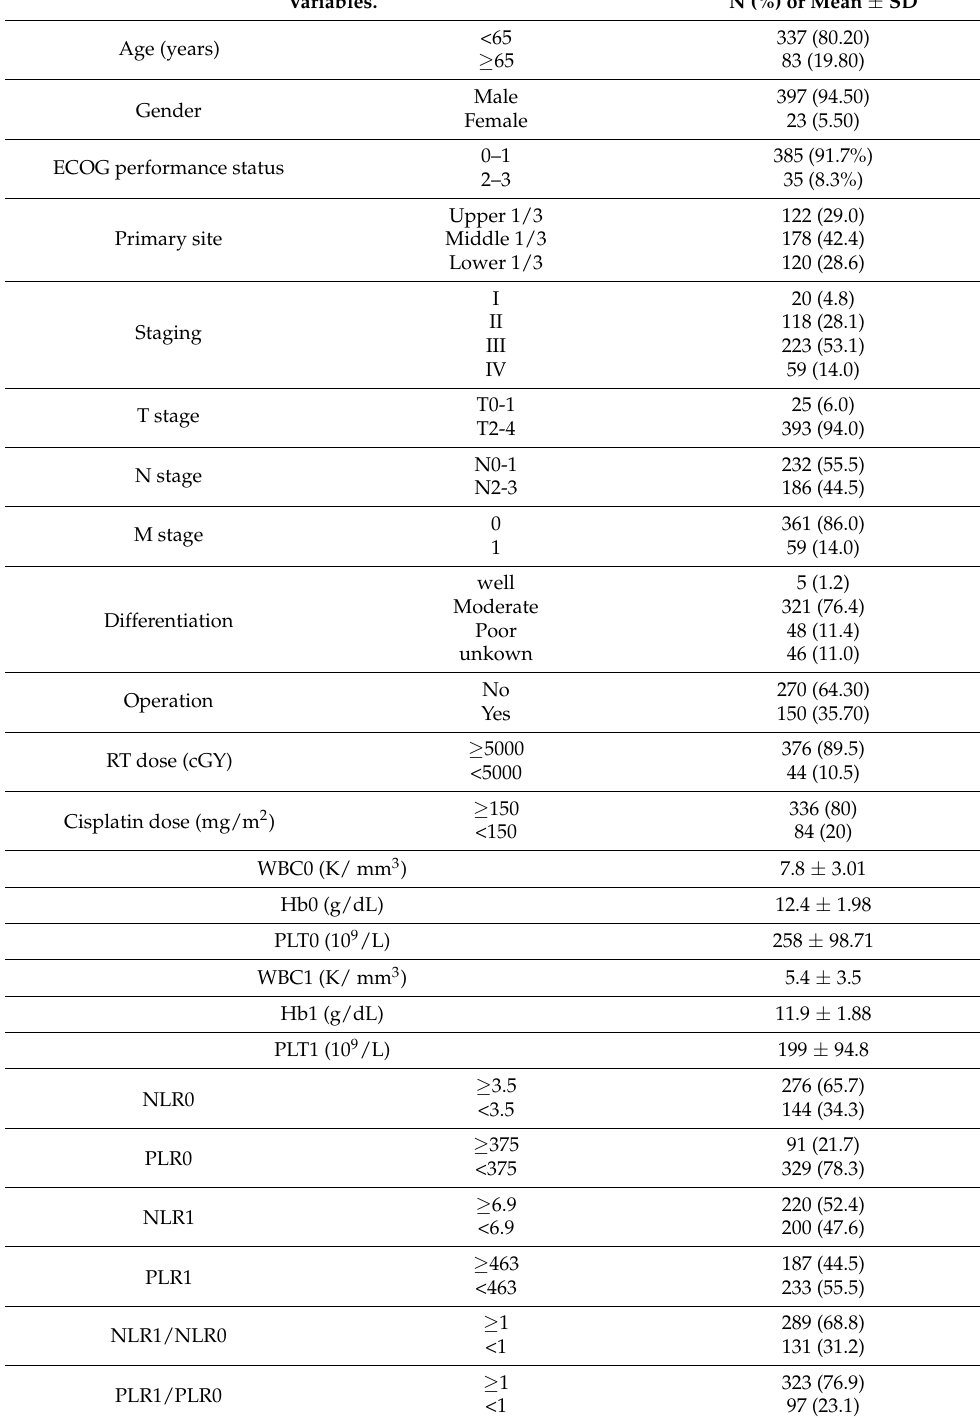
Table 1. Demographic and clinical characteristics of 420 enrolled